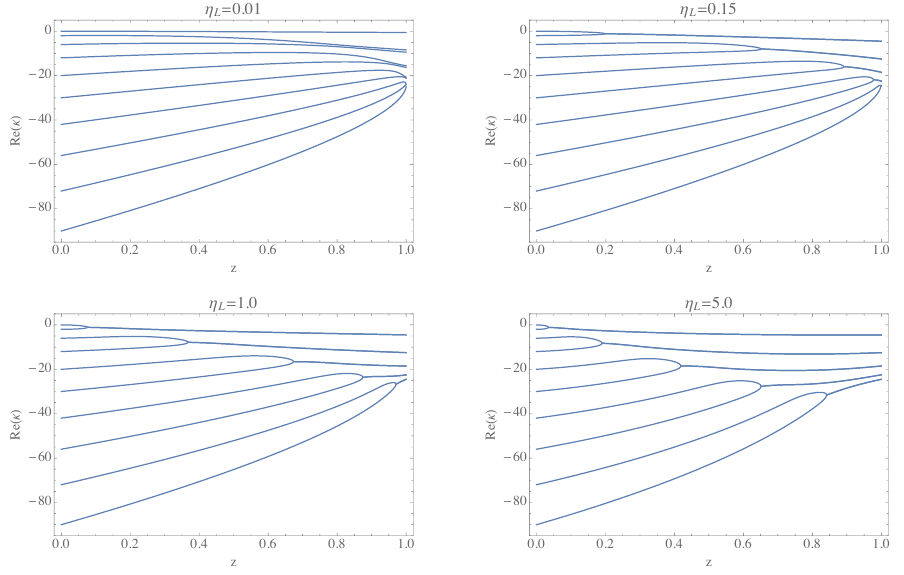
Figure 16 . Plot of values of Re( (cid:20) ) as a function of z for r = 10 with various values of (cid:17)